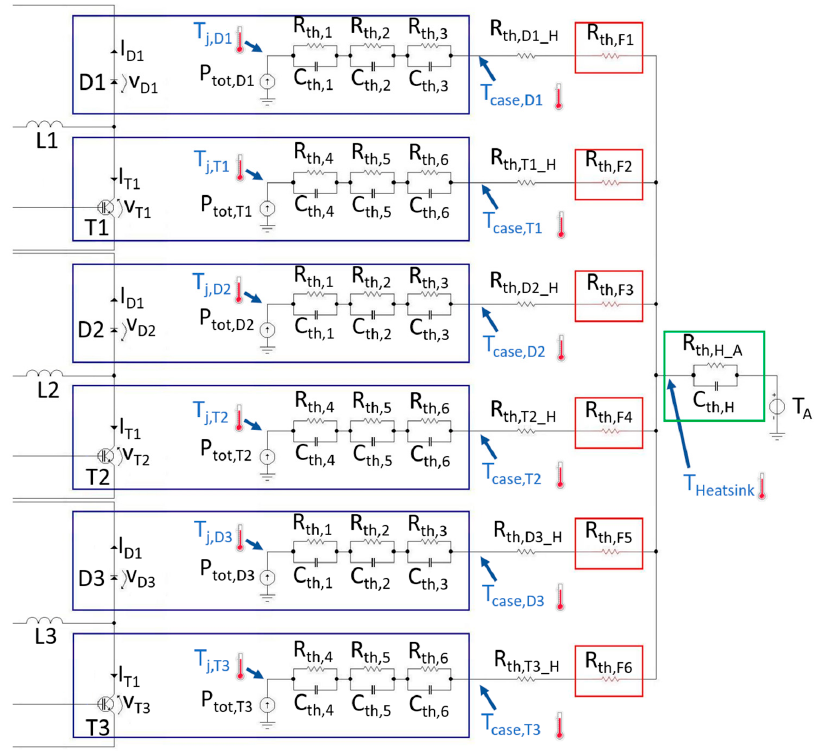
Figure 8. Thermal model of the cooling system.